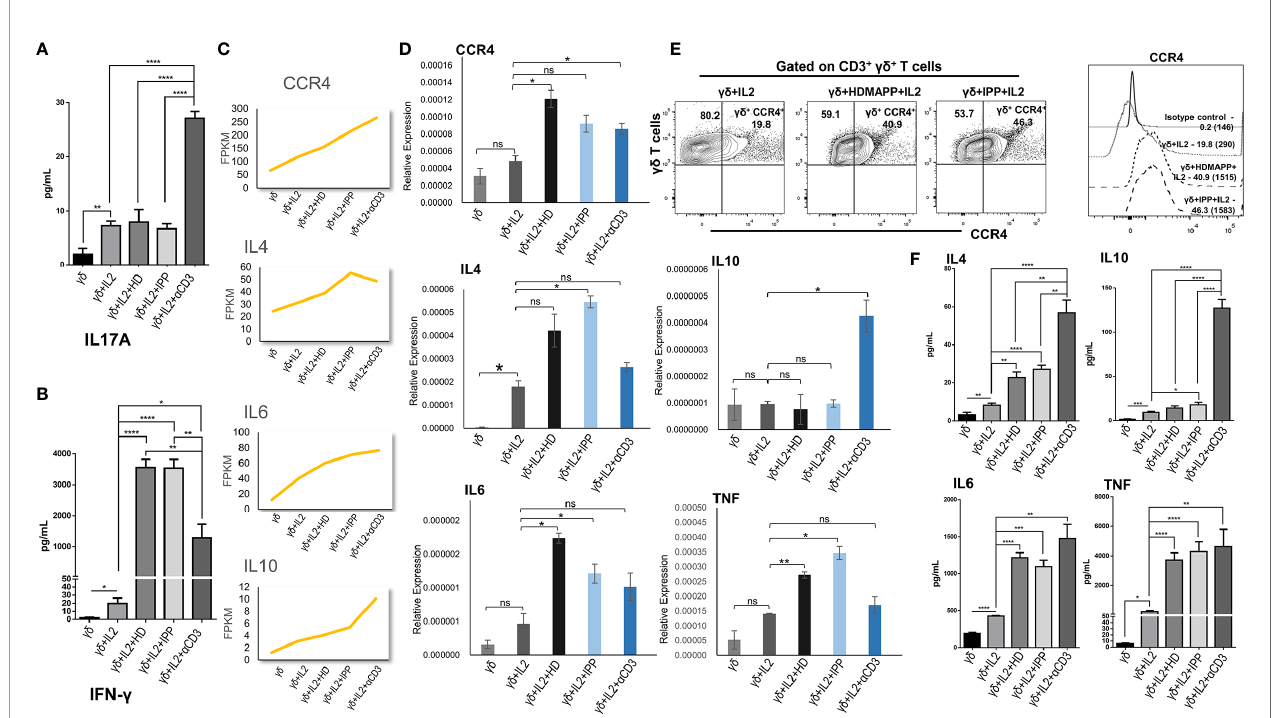
FIGURE 5 | Validation of transcriptomics data. The expression of cytokines, surface receptors, and key genes in differentially stimulated gd T cells isolated from peripheral blood lymphocytes of healthy individuals (n = 3) were assessed by cytokine bead array (CBA), multicolor fl ow cytometry, and quantitative real-time PCR (qRT-PCR), respectively. (A, B) The cell-free supernatants collected after 72 h were assessed for secreted cytokines IL17A and interferon- g (IFN- g ) using human Th1/ Th2/Th17 cytokine CBA kit. (C) Normalized FPKM plots showing the expression change of selected targets upon IL2, HDMAPP, IPP, and anti-CD3 treatments of gd T cells. (D) qRT-PCR analyses of the selected targets as shown in panel (C, E) Representative fi gure showing the expression of CCR4 gated on CD3+ gd + T cells in IL2, HDMAPP + IL2, or IPP + IL2 stimulated gd T cells after 72 h culture. The MFI of CCR4 expression on differentially stimulated gd T cells was analyzed after 72 h culture. The values in the inset represent the percent positive population, and the values in brackets represent the MFI of CCR4 expression. (F) CBA was used to ascertain the secreted protein levels of the target cytokines after 72 h culture as tested in panel (D) All the results indicated are mean ± standard error of the mean (SEM) of three independent experiments (*p < 0.05; **p < 0.01; ***p < 0.001; ****p < 0.0001, ns, non-signi fi